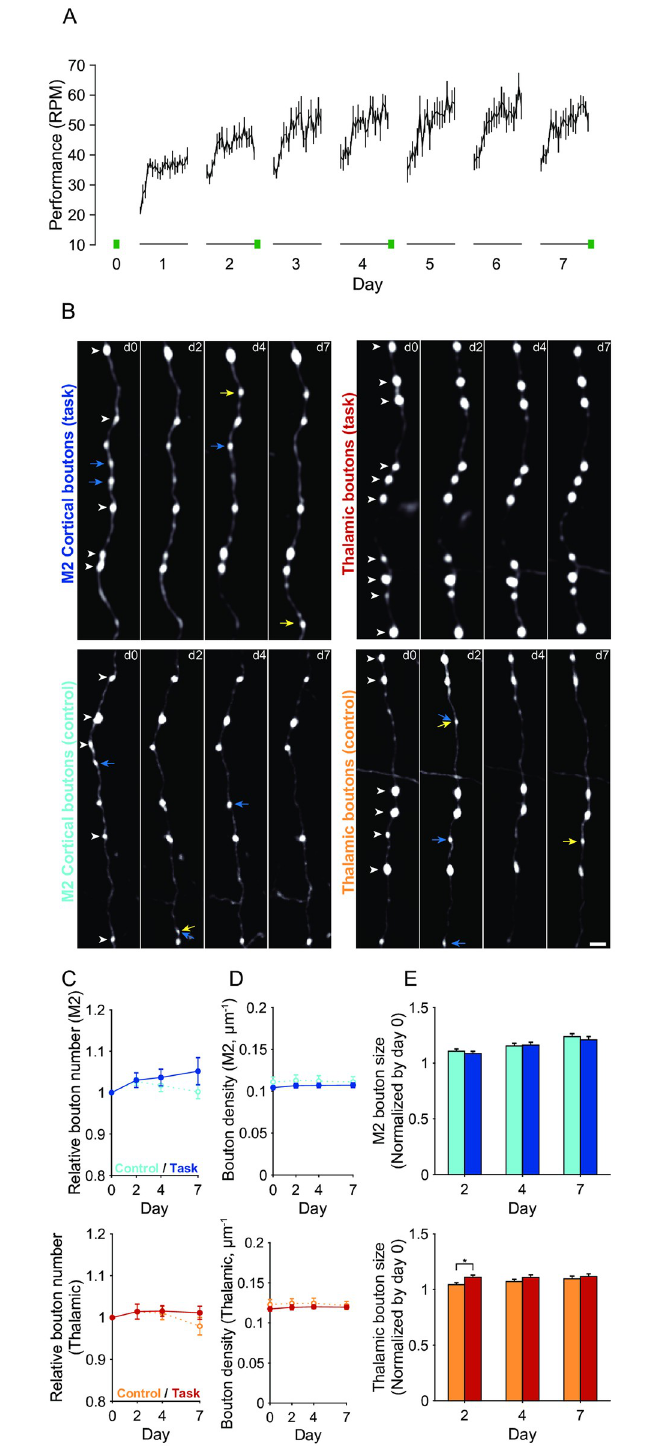
Fig 3. Two-photon imaging of the same M2 and thalamic boutons during motor learning. (A) Averaged motor performance over the 7 training days (n = 8). Performance is defined as the rotation speed at which the mice were unable to keep up (20 trials for each training day). Two-photon imaging was conducted on day 0 and on days 2, 4, and 7 after training (green bars). (B) Representative two-photon images of M2 (left) and thalamic (right) boutons in the trained (top) and control (bottom) mice on days 0, 2, 4, and 7. White arrowheads on day 0 images indicate the boutons